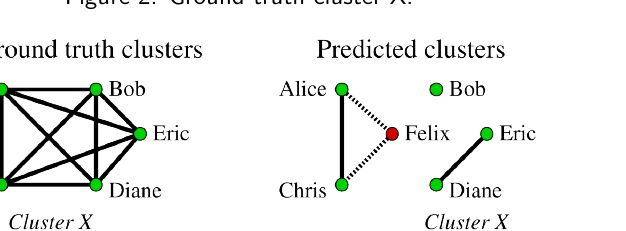
Figure 2: Ground-truth cluster